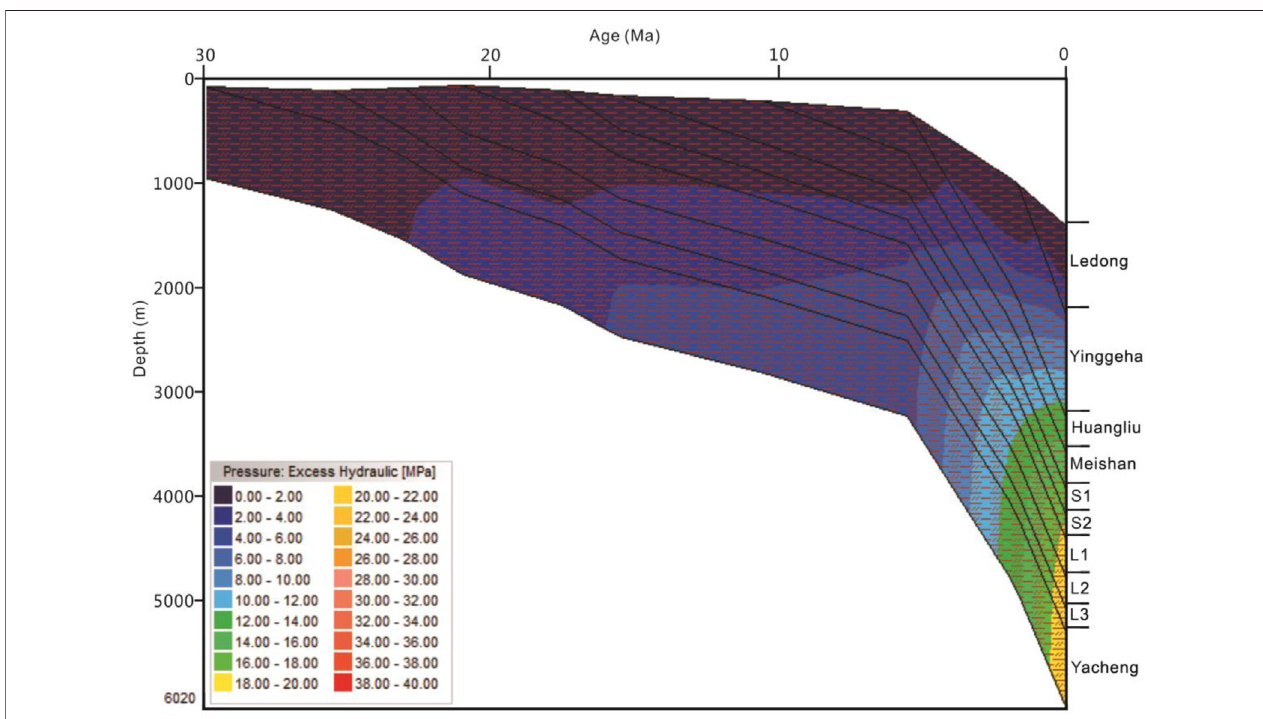
FIGURE11| Modelling oftheevolution ofexcess pressureat positionMN in Figure 8 ,Based on thismodel overpressure wasgenerated beginning approximately 5.5 Ma.